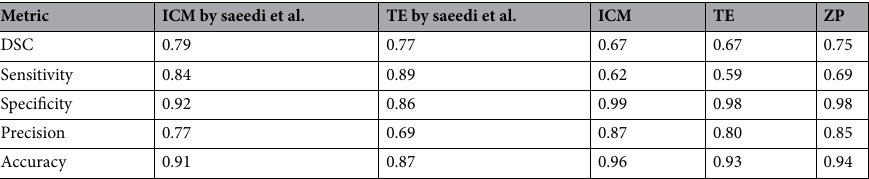
Table 2. Comparison of the results by Saeedi et al., and ours in the same database. ICM Inner cell mass, TE Trophectoderm, ZP Zona pellucida, DSC Dice Similarity Coefficient.